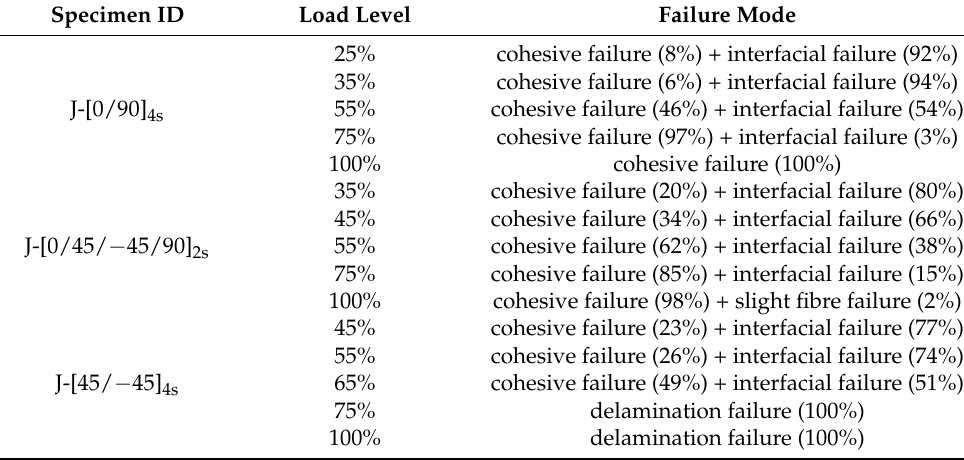
Figure 8. Diagram of failure mode of joints under different load levels. Table 7. Failure mode details of the joints.